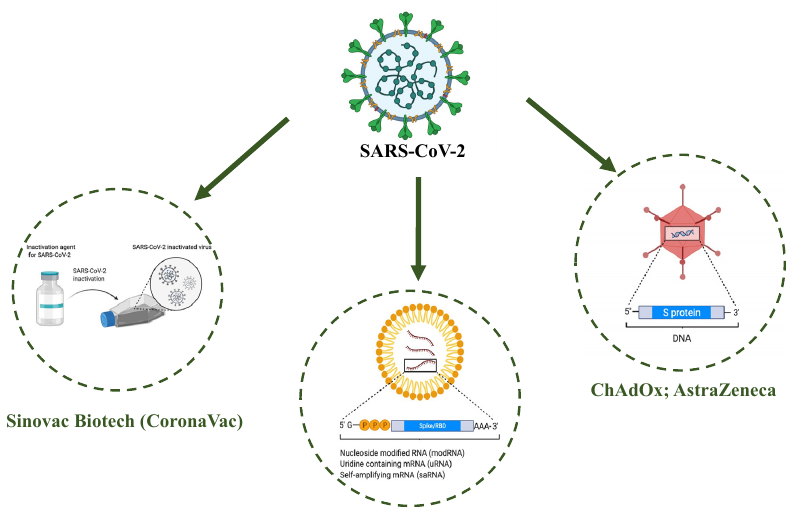
Figure 1. SARS-CoV-2 vaccines mechanism of actions.